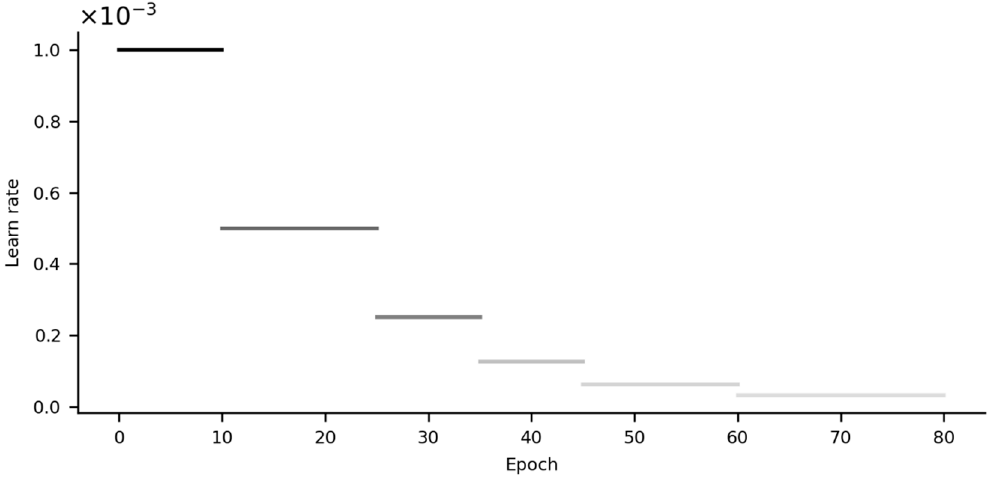
Figure 8. The adjusting strategy of the learning rate.